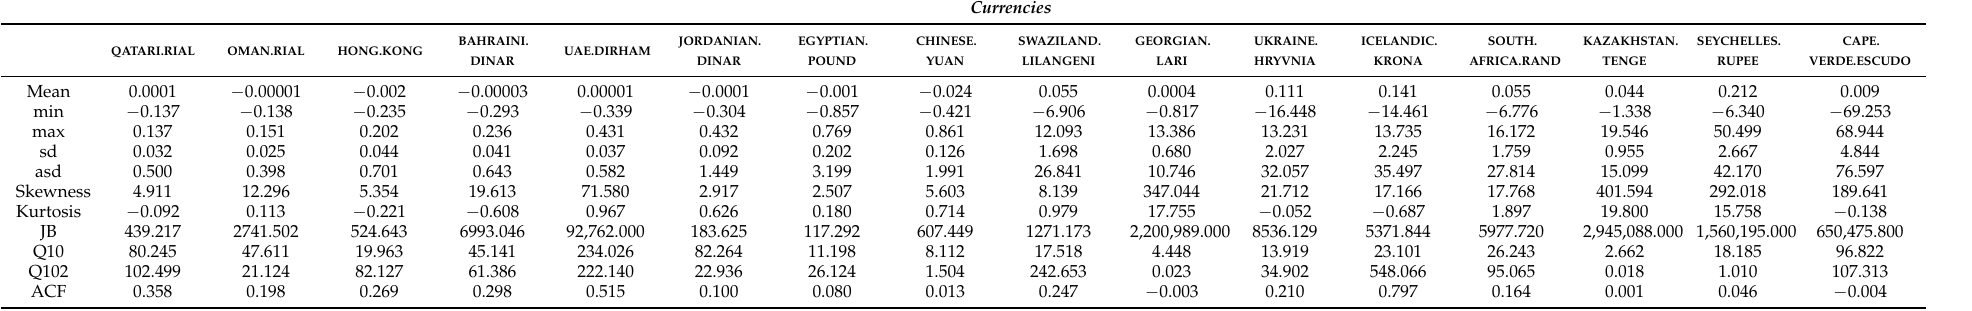
Table 3. Summary statistics of classified Forex with lower and higher behavioral